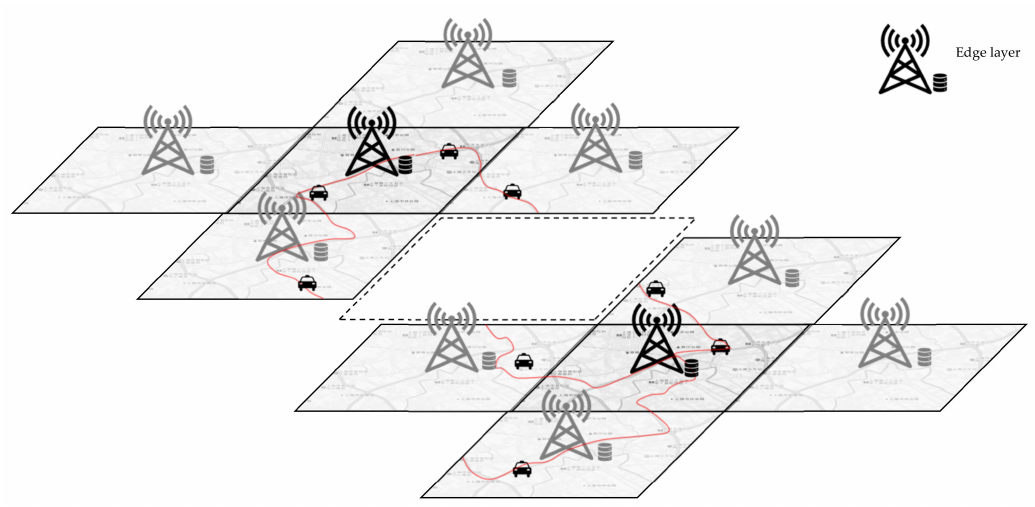
Figure 2. Spatio-temporal data